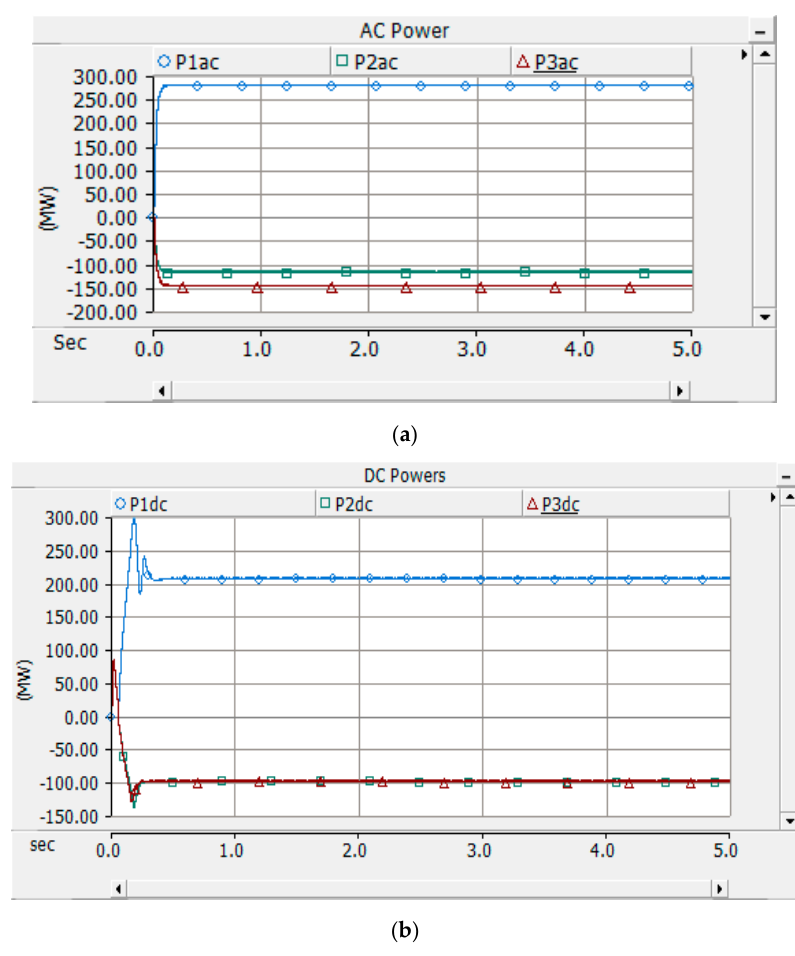
Figure 8. ( a ) Pure AC power in area-1, area-2, and area-3; ( b ) active power flow measured on AC side of VSC1, VSC2, and VSC3. AC and DC power flow in area-1 is negative, while power flowing in area-2 and 3 is positive. Total power flow in area-1, -2, and -3 is given by P 1source , P 2source, and P 3source , which is the sum of AC and DC power flow in each area as shown in Figure 9.